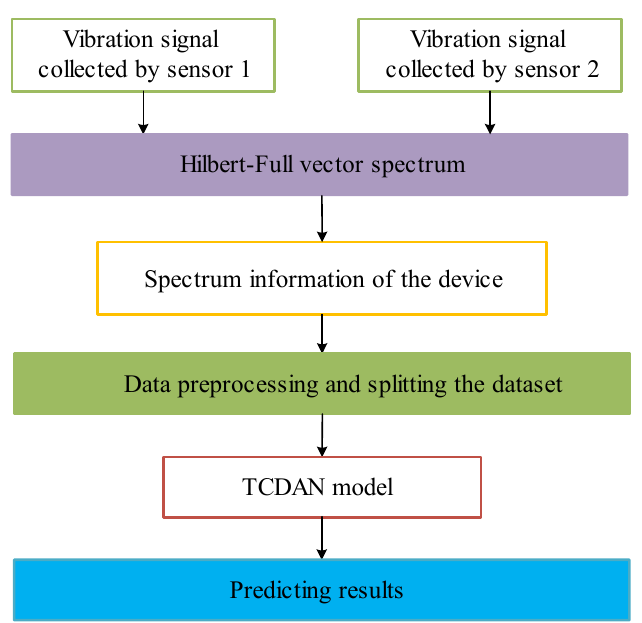
Figure 7. The flowchart of fault prediction.